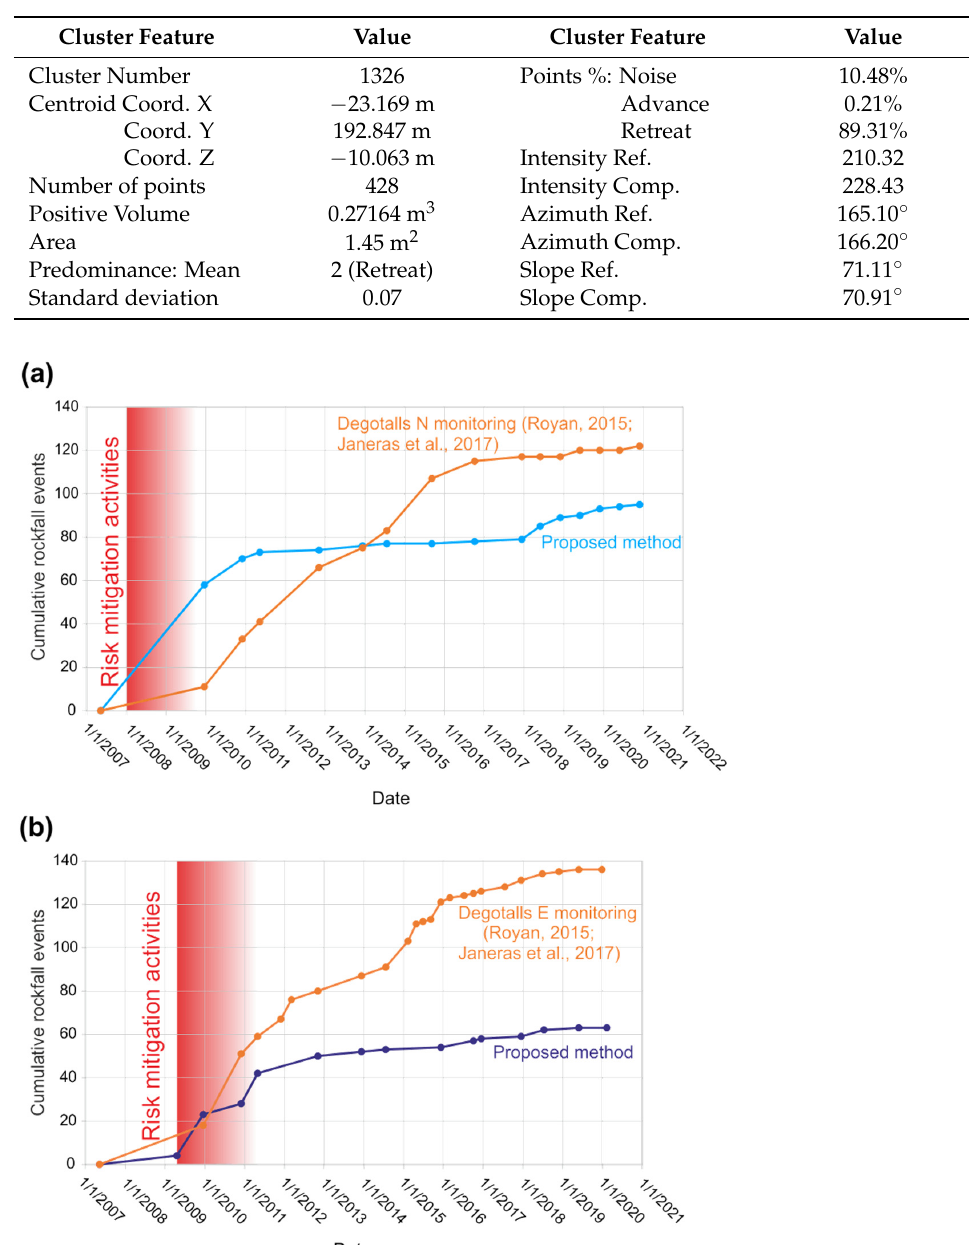
Table 11. Summary of features of the cluster shown in Figure 9. Cluster #1326 (Degotalls E, south section, period 2017–2019).